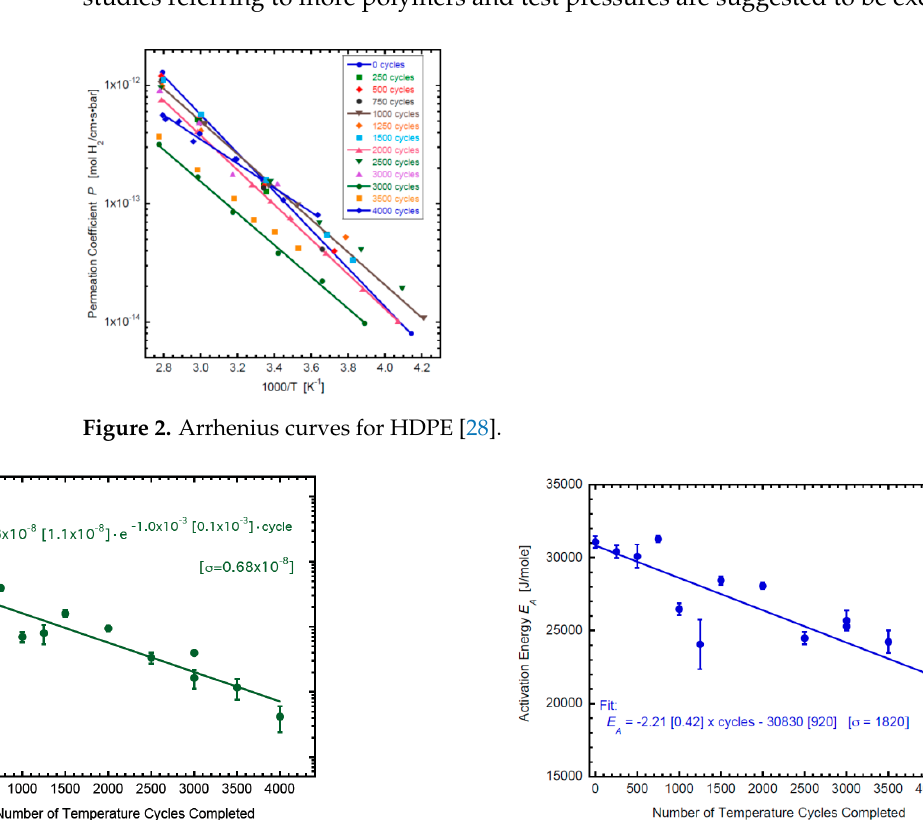
Figure 1. Arrhenius curves for 3 polymers [27].